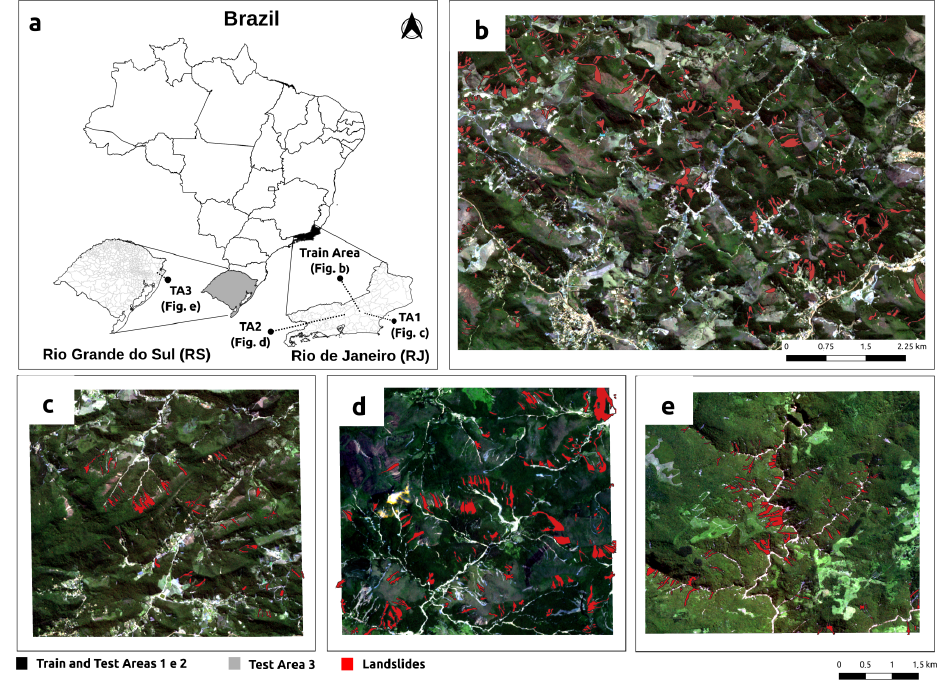
Figure 1. Location of the train and test areas used to train and evaluate the deep learning models. ( a ) Location of the train and test areas in Brazil. ( b ) Train Area. ( c ) Test Area 1 (TA1). ( d ) Test Area 2 (TA2). ( e ) Test Area 3